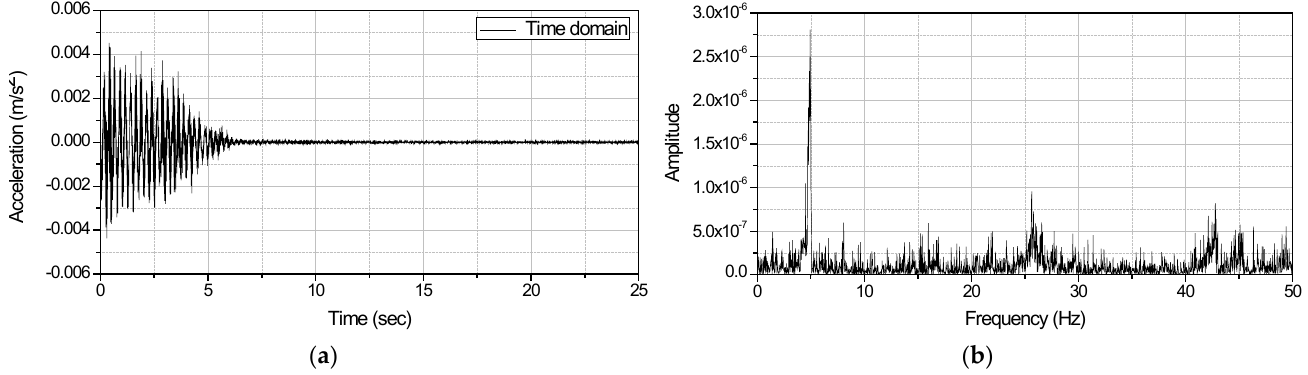
Figure 4. Cross-correlation signal measured in the Imgi 2nd Bridge: ( a ) Time domain; ( b ) Frequency domain.